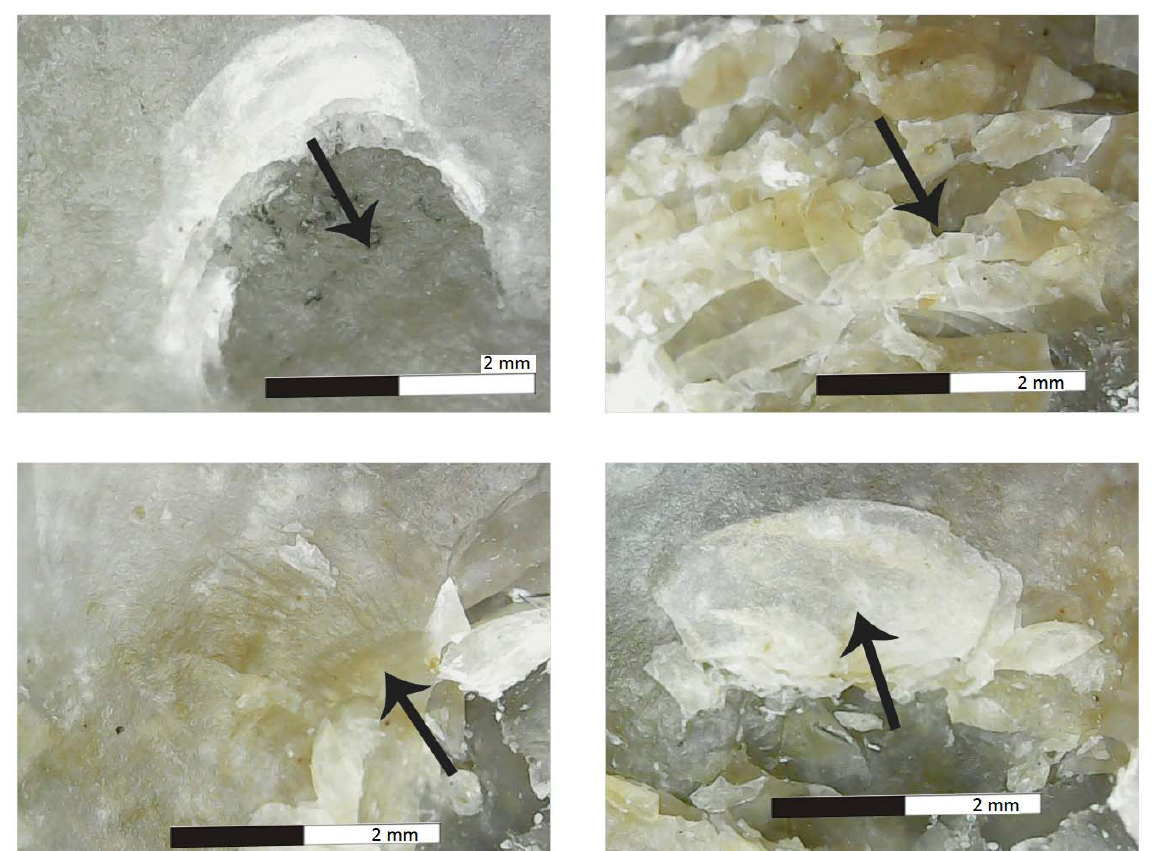
Figure 4. Percussion marks of the flint that can aid in the identification of the use direction of a hammerstone.